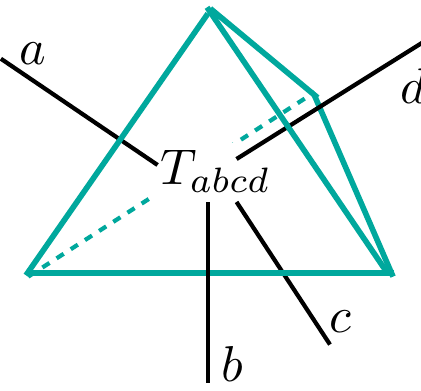
Figure 2 . We show the correspondence between a tensor and a building block of space.